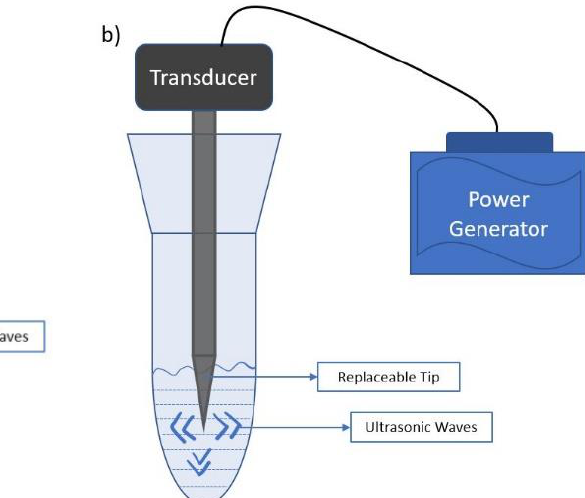
Figure 3. US bath ( a ) and US probe ( b ). Adapted from [56].